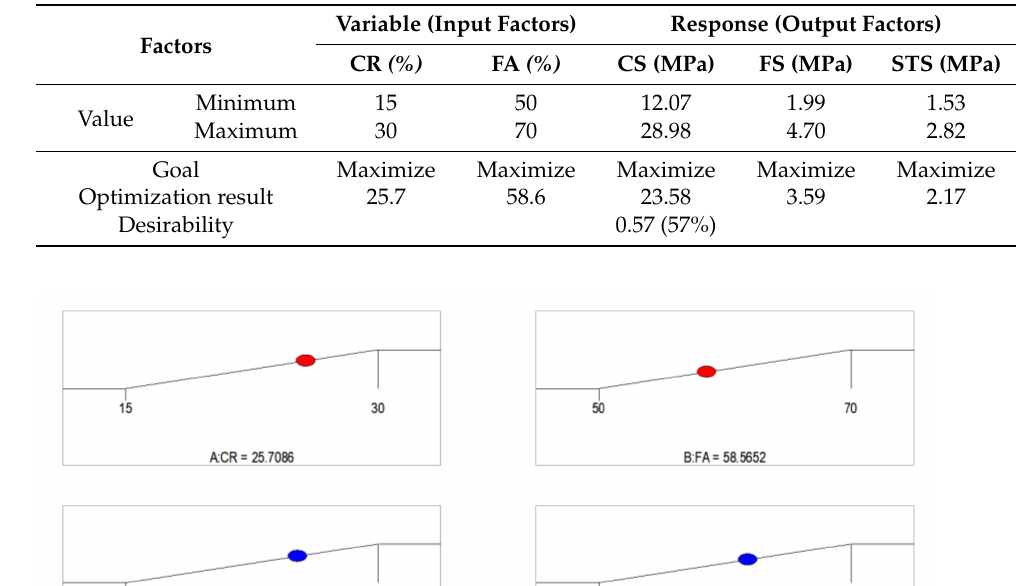
Table 6. Optimization criteria and result.